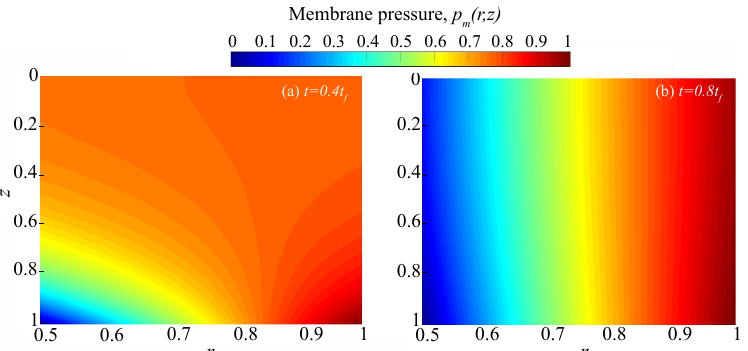
Figure 4. Contour plots showing pressure in the membrane region p m ( r , z ) at ( a ) t = 0.4 t f ; and ( b ) t = 0.8 t f . Parameter values are φ = 0.5, l = 0.5, Γ = 10, N = 1, β = 0.02, ρ b = 2, b = 0.5, and (cid:101) ∗ = 0.5.